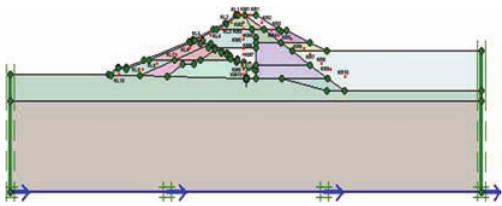
Figure 10: Location of stress points for Kitayama